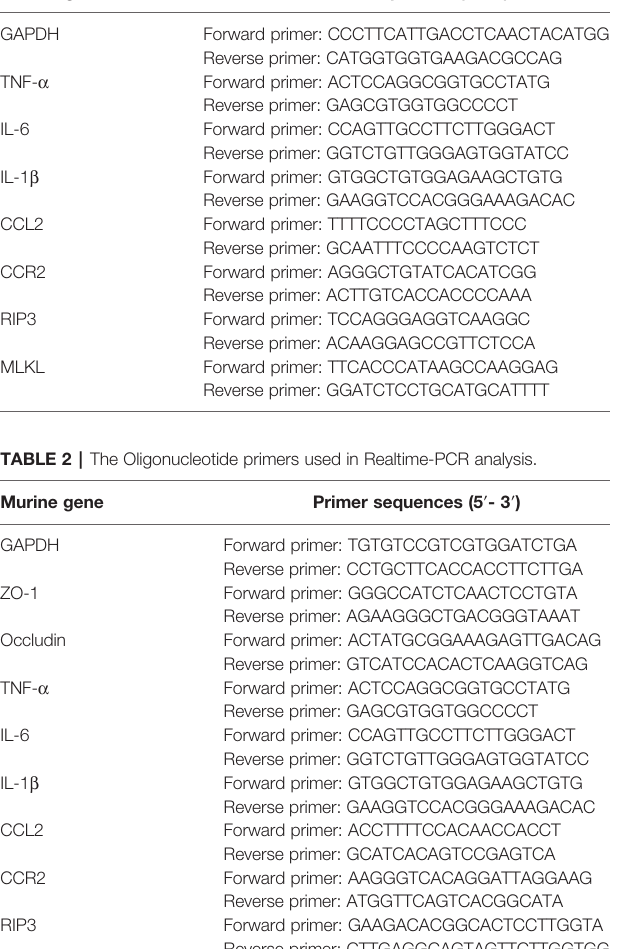
TABLE 1 | The Oligonucleotide primers used in Realtime-PCR analysis. Human gene Primer sequences (5 ′ - 3 ′